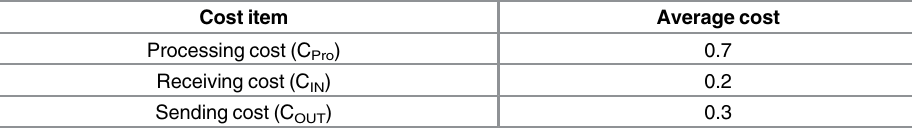
Table 1. Power consumption of requester cost